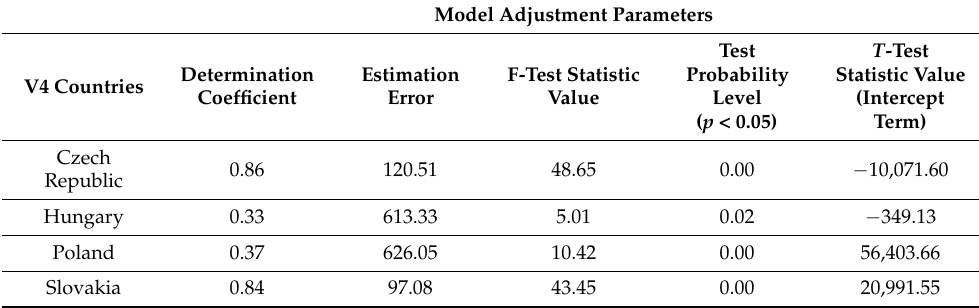
Table 4. Evaluation results of the significance of the parameters of the multiple linear regression model. Step